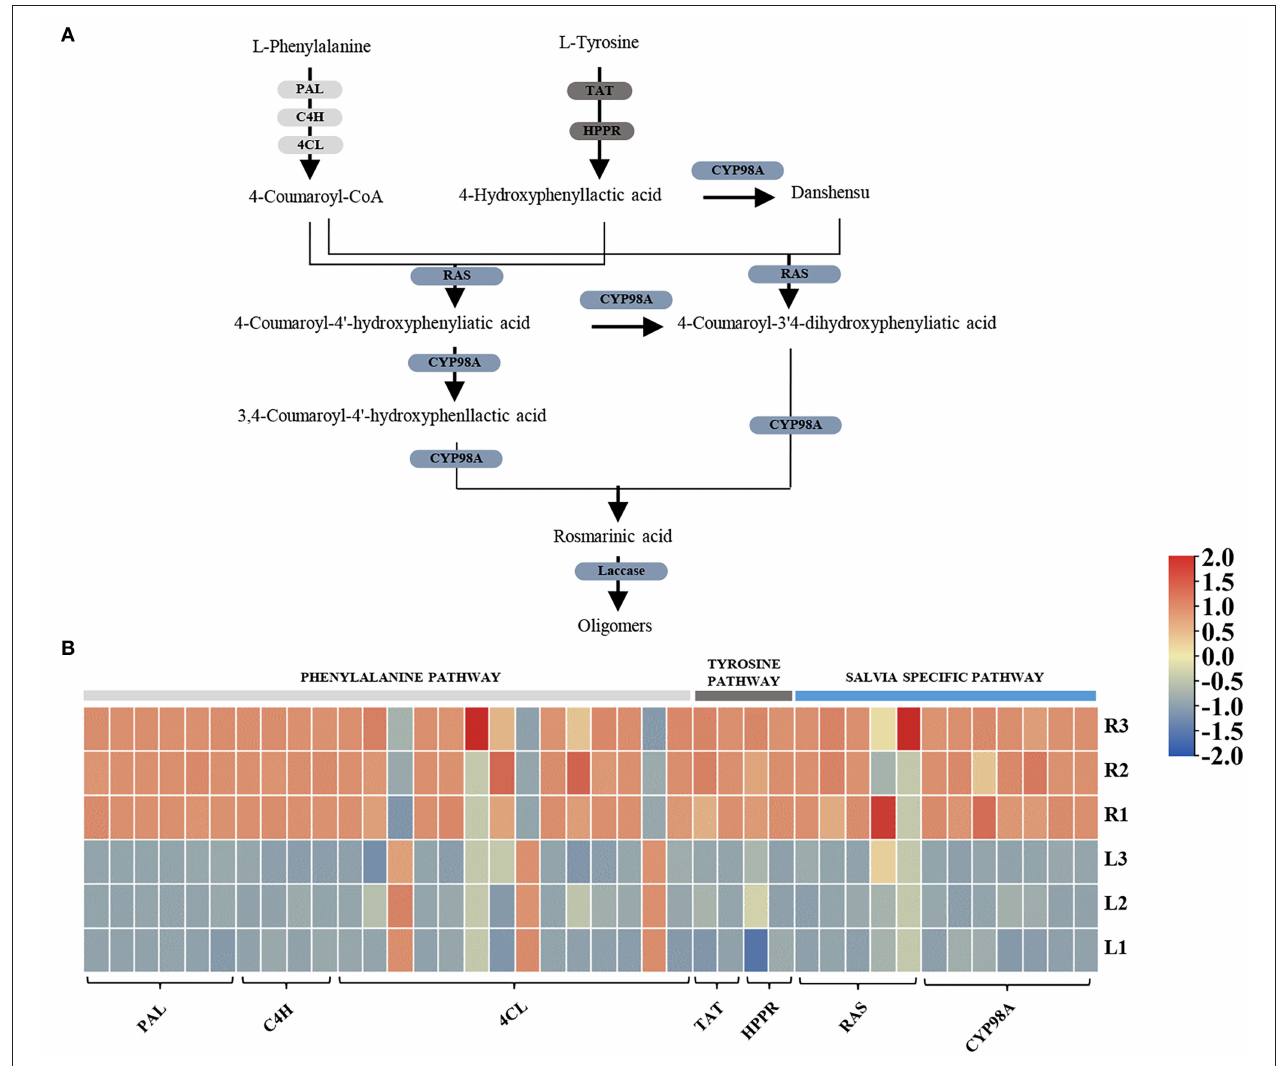
FIGURE 6 | A proposed biosynthetic pathway of phenolic acids (PAs) in S. apiana . (A) Pathways and genes involved in PAs biosynthesis. (B) Expression profile of candidate PAs biosynthetic genes. Three biological replicates from the leaf (L) and root (R) were plotted individually. PAL, phenylalanine ammonia lyase; C4H, cinnamate 4-hydroxylase; 4CL, 4-coumarate:coenzyme A ligase; TAT, tyrosine aminotransferase; HPPR, hydroxyphenylpyruvate reductase; RAS, rosmarinic acid synthase; CYP, cytochrome